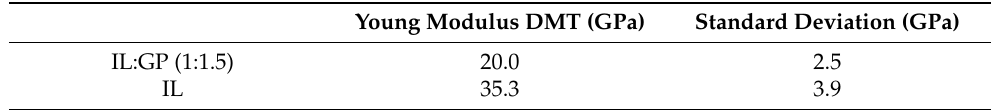
Figure 8. Images of UV imprint of [(N 11 VB) 2 Pr][Cl] + PG. Optical microscopy and AFM image of ( a ) checkerboard pattern, and ( b ) relief diffraction grating 1.7  m . AFM data was acquired with the use of a Park Systems XE-70 (Suwon, Korea). Table 3. The comparison of Young’s modulus for UV polymerized layers of IL prepared with glycol and ethanol, measured with AFM in the QNM